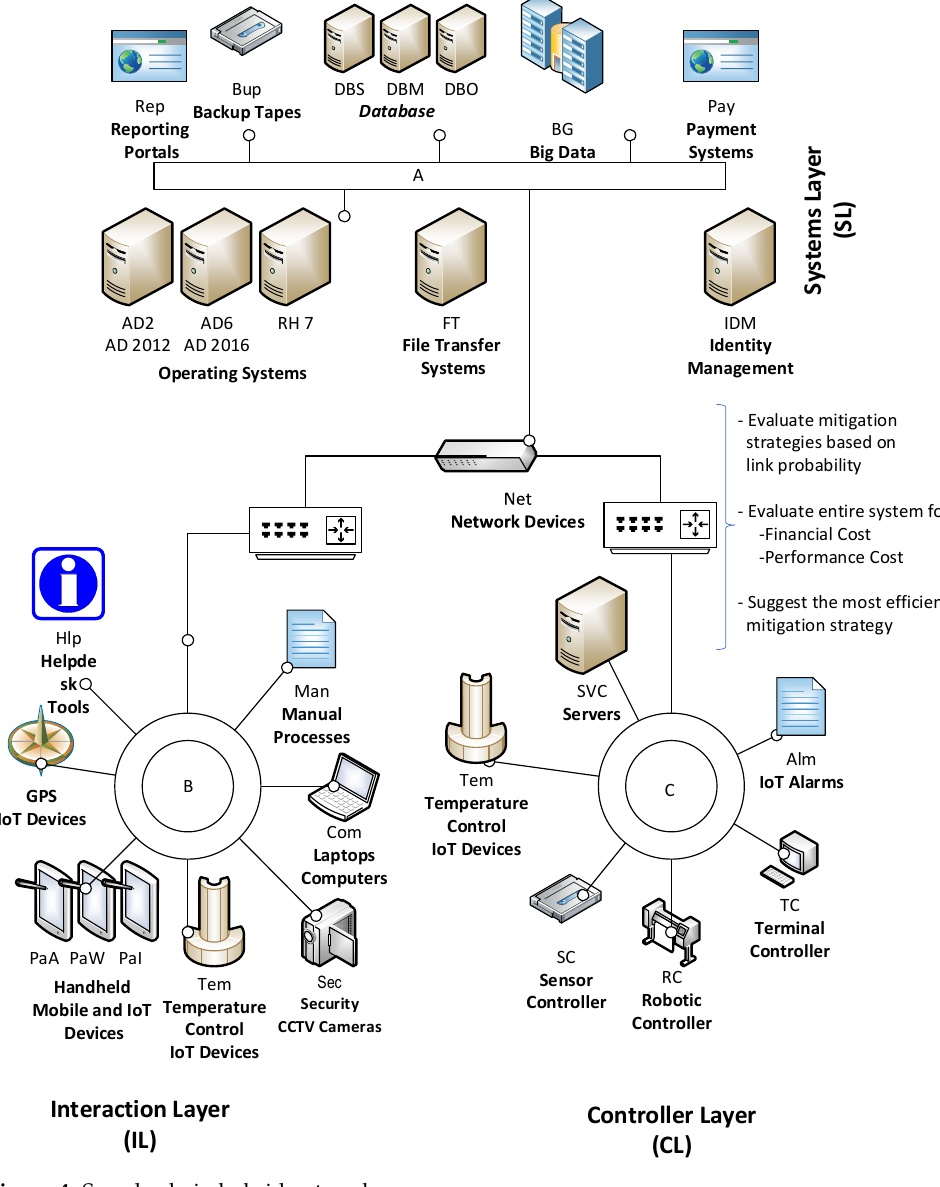
Figure 4. Supply chain hybrid